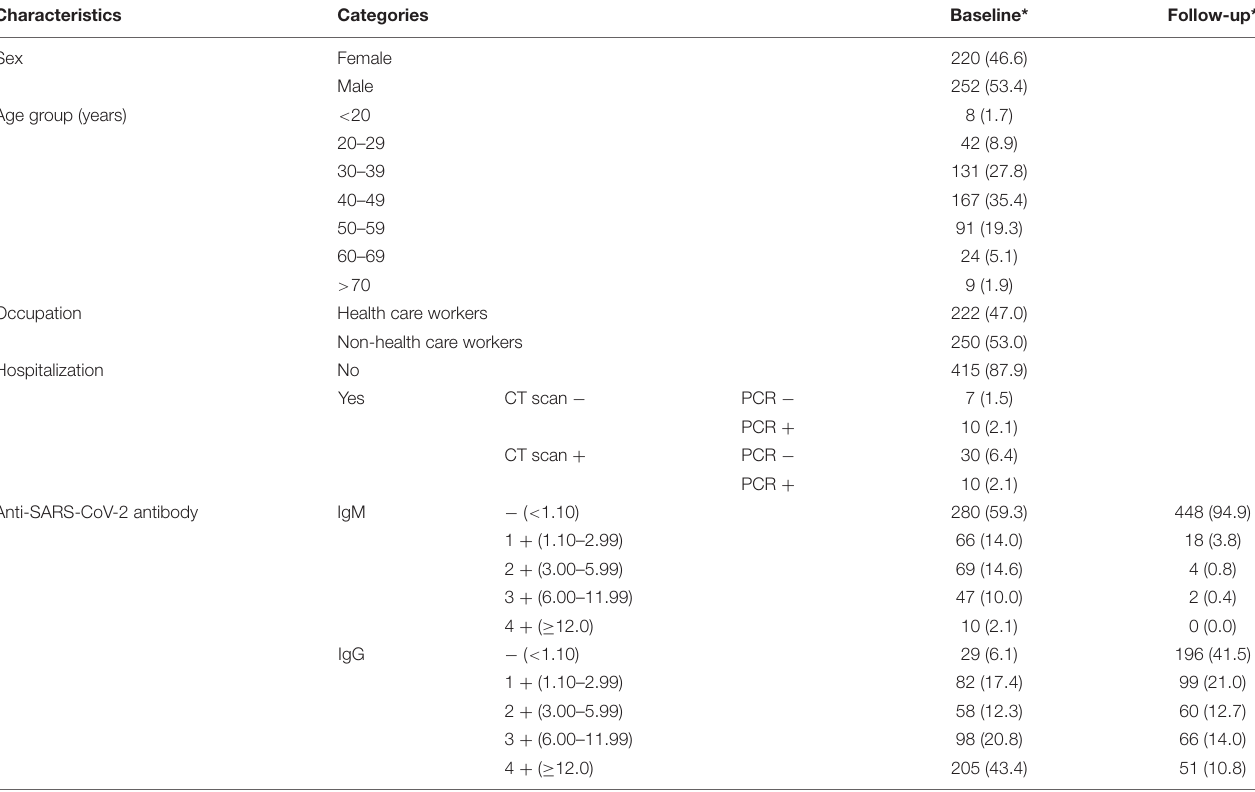
TABLE 1 | Basic characteristics and anti-SARS-CoV-2 serologic profile of 472 COVID-19 patients.